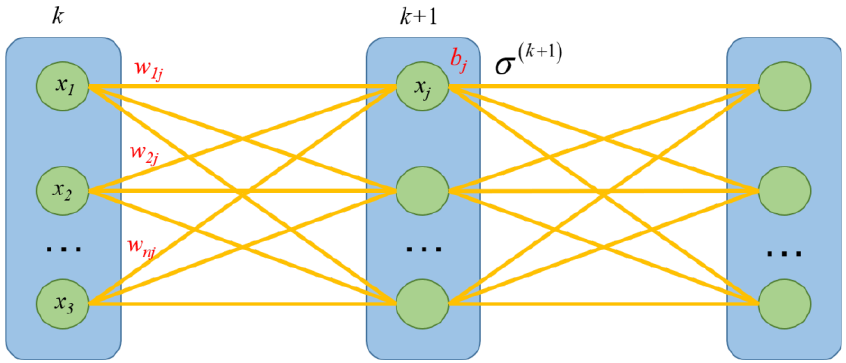
Figure 1. Diagram of neural network neurons.